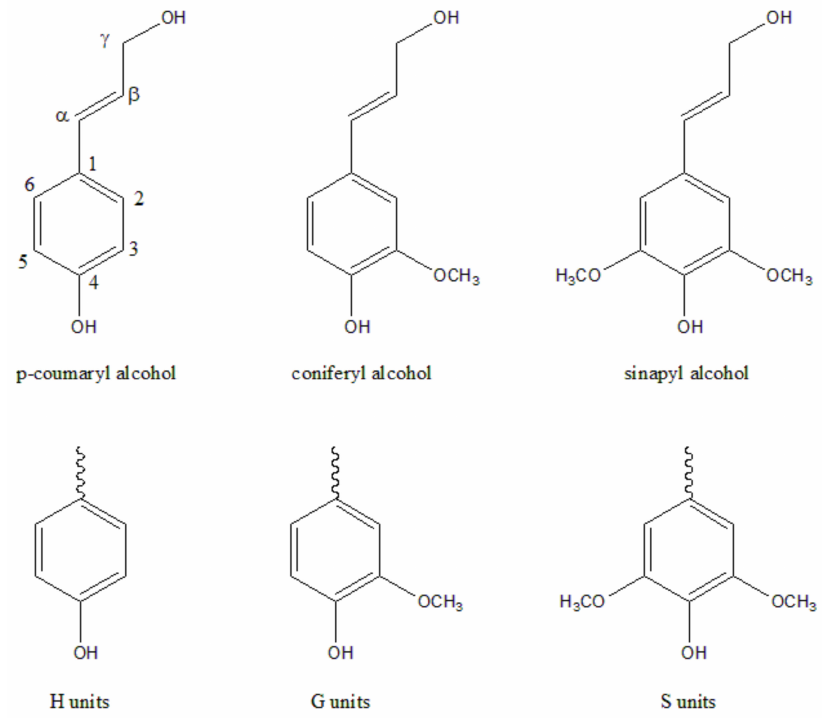
Figure 4. Main structural units of lignin.